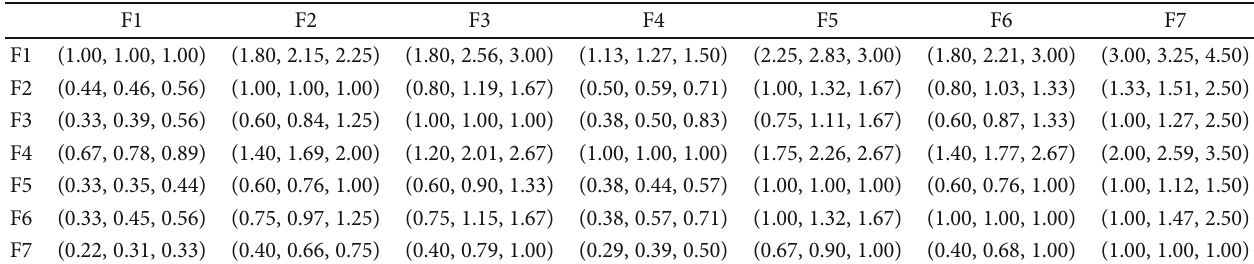
Table 2: Group fuzzy pairwise comparison matrix.